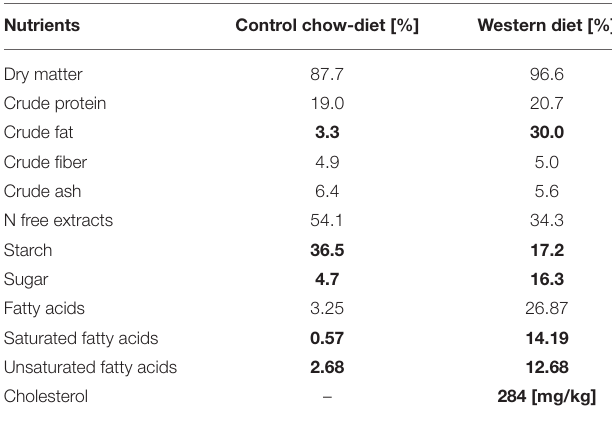
TABLE 1 | Number of animals per group. TABLE 2 | Percentage composition of diet ingredients.